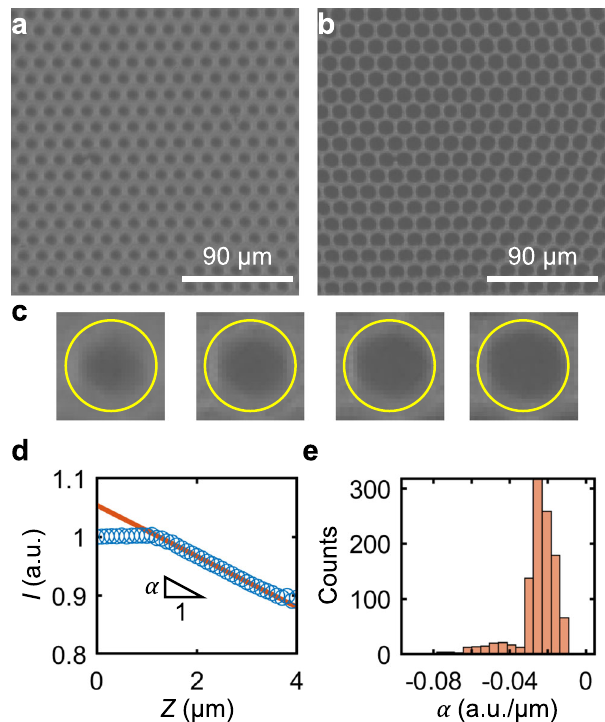
Fig. 2 Calibrating the cantilever-free probe array. Optical images of the cantilever-free probe array out of contact at a probe array extension Z = 1 μ m and in contact at b Z = 4 μ m. c Image of one probe with a circular region of interest (ROI) denoted by the yellow circle at Z = 1, 2, 3, and 4 μ m (from left to right). d Averaged I for a single probe vs. Z shown with the linear fi t used to estimate slope α . e Histogram of α from the calibration of all 1088 probes in a single